Question: Author a descriptive caption for the visualization shown.
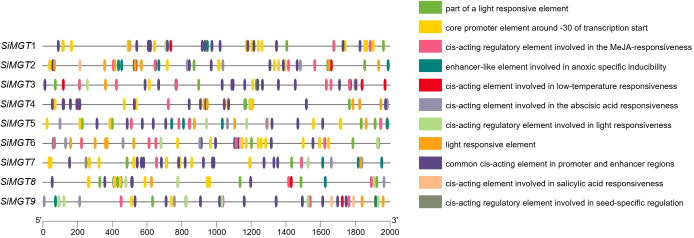
Answer: Distribution of cis-acting elements in the 2000 bp promoter regions of SiMGT genes. Different colors represent distinct types of cis-acting elements (light-responsive, stress-responsive, hormone-responsive). The scale bar indicates the length of the promoter region (bp), with the transcription start site at position 0.